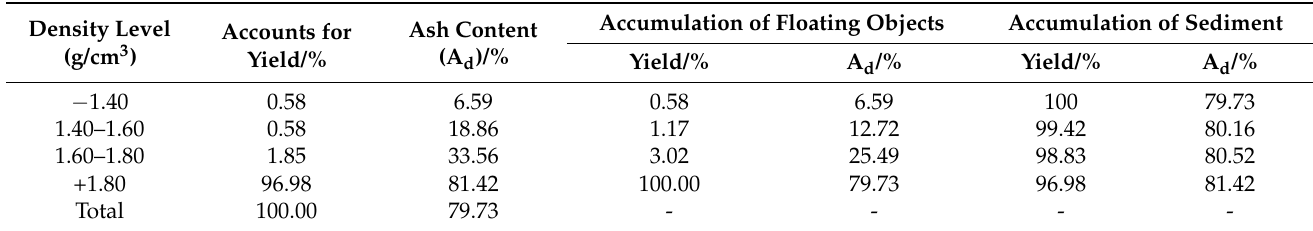
Table 2. Density composition of mineral-enrichment area in − 0.045 mm tailings.